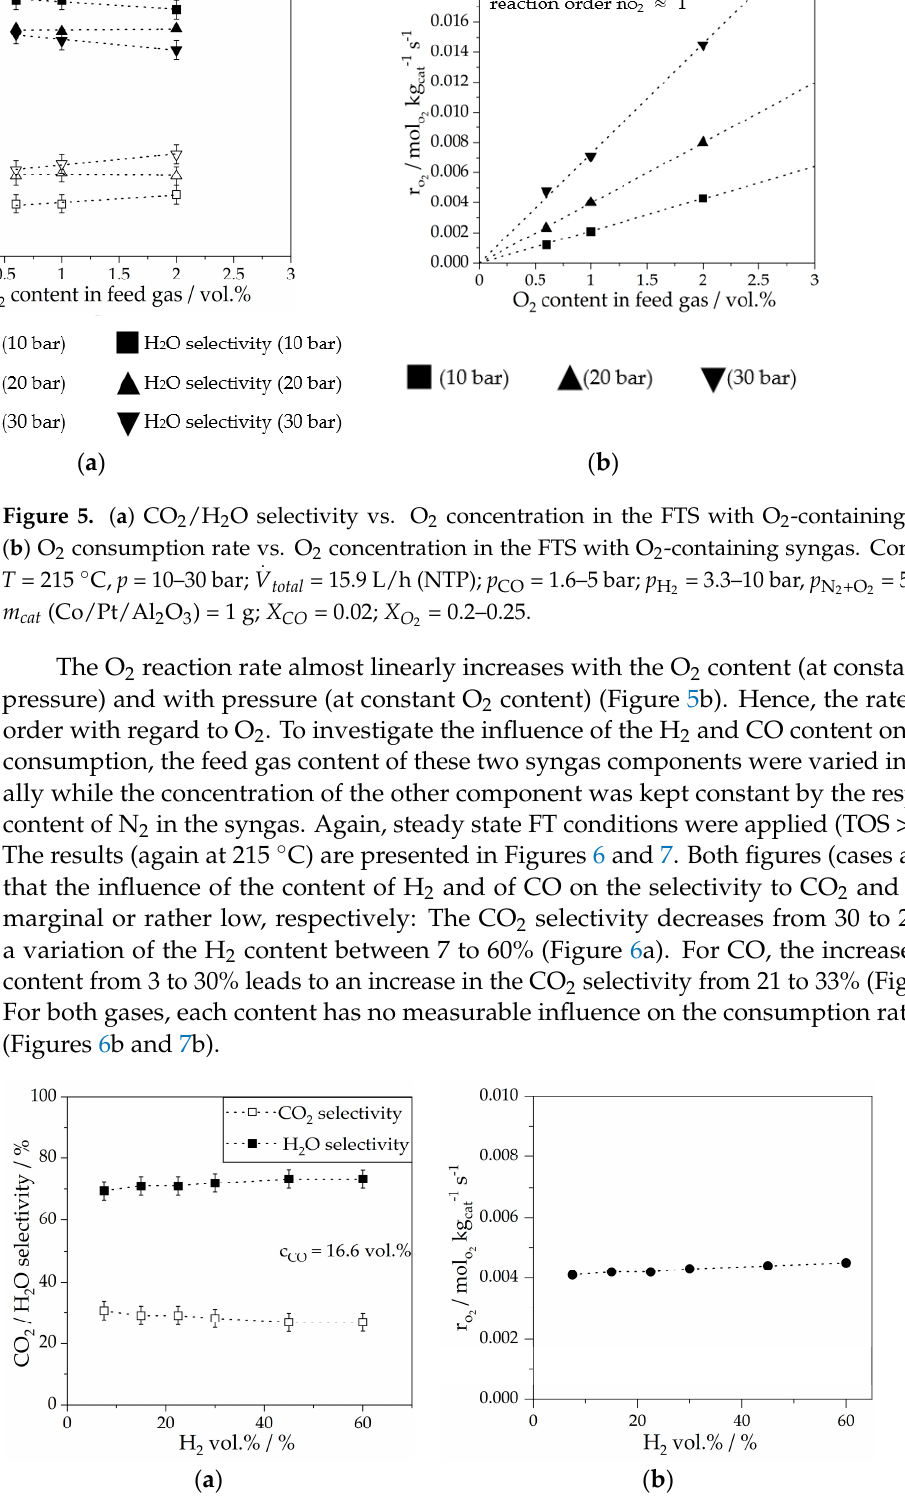
Figure 6. ( a ) Selectivity of O 2 products for different H 2 concentrations. ( b ) Oxygen reaction rate for different H 2 concentrations. Conditions: p = 20 bar; T = 215 °C; 𝑉(cid:4662) total = 15.9 L/h (NTP); p CO = 3.3 bar; p H2+N2 = 16.5 bar; p O2 = 0.2 bar; m cat (Co/Pt/Al 2 O 3 ) = 1 g; X CO = 0.02; X O2 = 0.2.